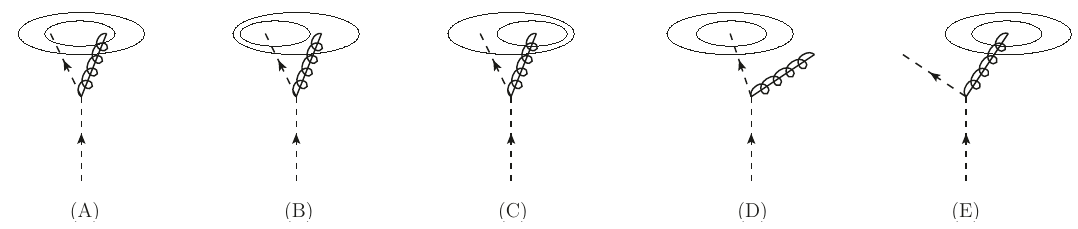
Figure 3 . The (cid:12)ve con(cid:12)gurations that enter for the quark subjet function at O ( (cid:11) s ): (A) the quark and gluon are inside the jet and subjet, (B) only the quark is inside the subjet but both partons are in the jet, (C) only the gluon is inside the subjet but both partons are in the jet, (D) only the quark is inside the jet and subjet, (E) only the gluon is inside the jet and